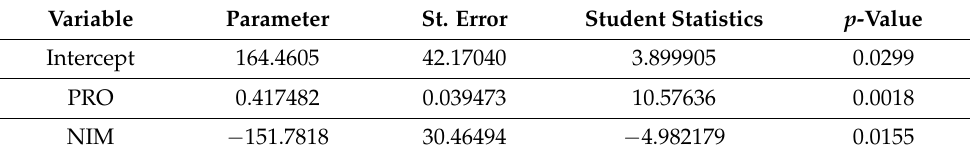
Table 16. Results of regression analysis of a statistically significant